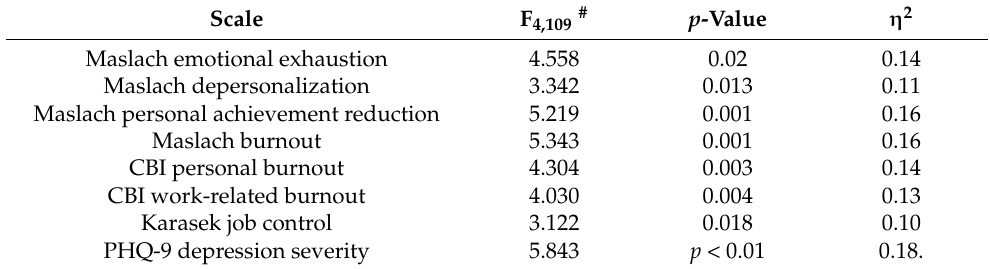
Table 6. Burnout, depression, and occupational stressors subscales comparison regarding age groups.